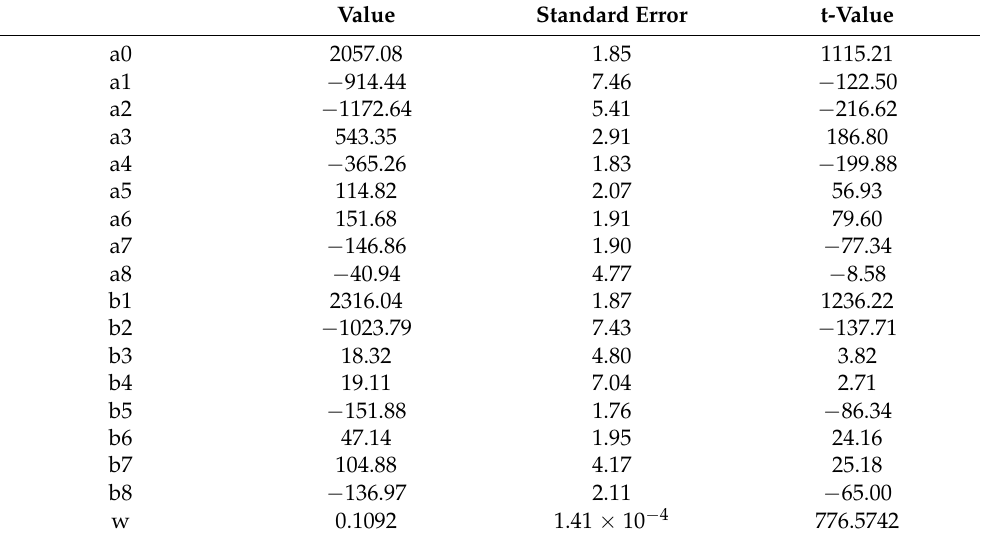
Table 2. The coefficients of the eighth-order Fourier model for fitting the XRD data of the averaged amorphous